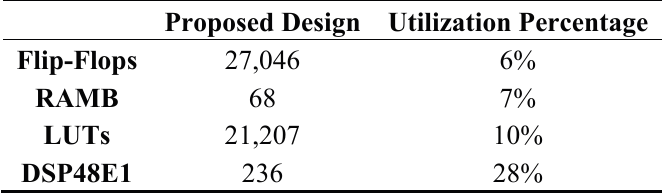
Table 1. Resource consumption of the synchronization algorithm implementation in a Xilinx XC7K325T